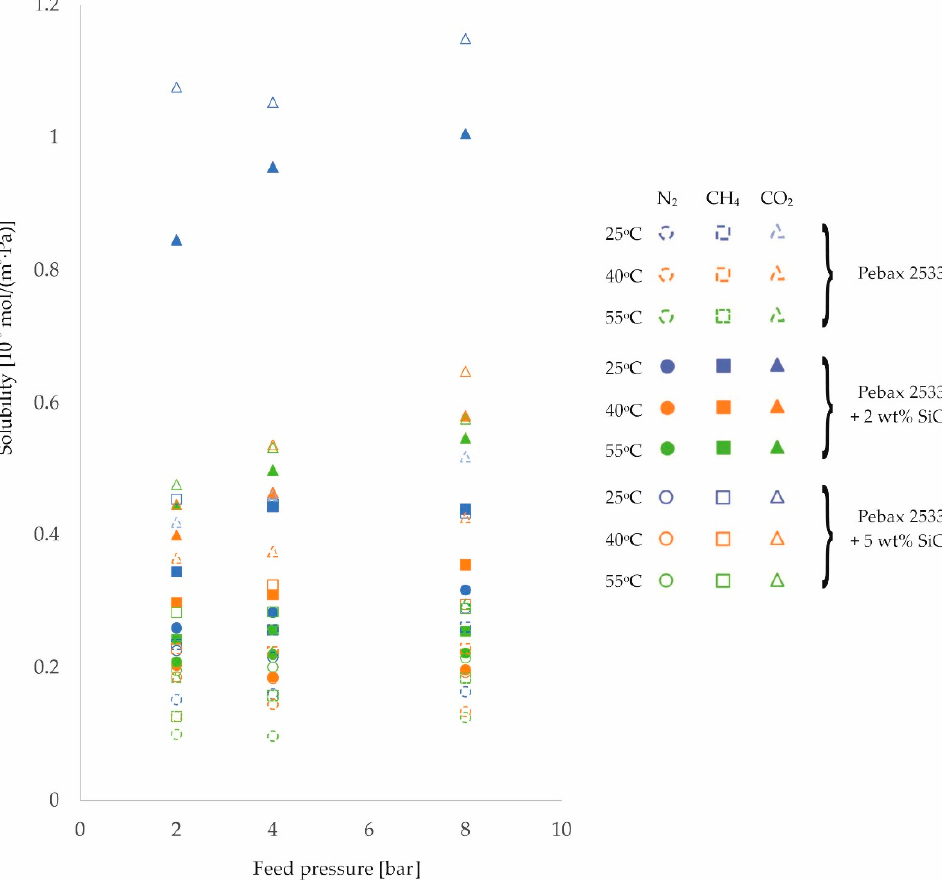
Figure 7. Change in solubility coefficient values of homogeneous membrane and heterogeneous membranes containing SiO 2 for different feed pressure and temperature values.